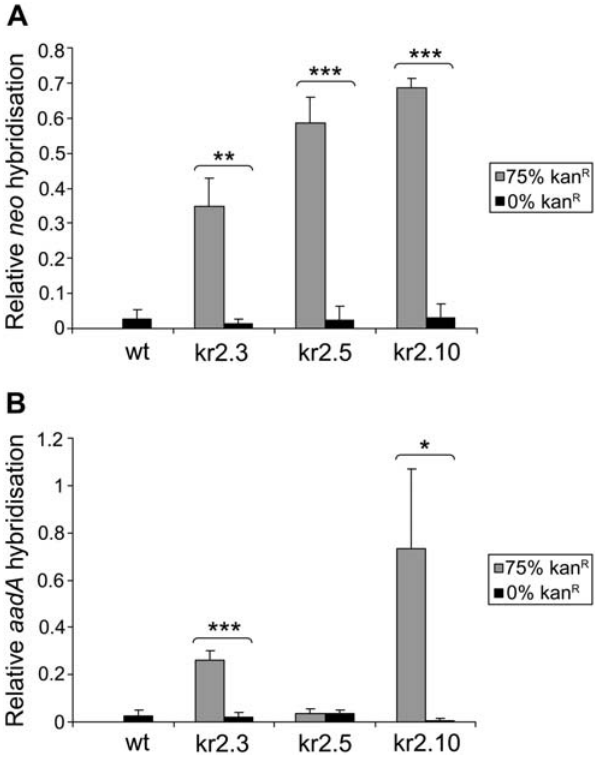
Figure 3. PCR analysis of kr lines with reduced levels of kanamycin resistance. A–C. PCR of neo from 6 plants grown from seeds of a normally segregating self-fertilised seed capsule (75% kan R ) and 6 plants grown from seeds of a capsule which showed no kanamycin resistant progeny (0% kan R ) for each of kr2.3 (A), kr2.5 (B) and kr2.10 (C) (see Figure 1). D. PCR of neo from progeny of a self- fertilised seed capsule of kr2.9 which gave 50% kanamycin resistant progeny. Results for 12 plants are shown; this is representative of a larger experiment in which 36 plants were tested (see text). In all cases control PCRs with rbcS primers are also shown. The neo primers amplify a single product of approximately 800 bp. The rbcS primers amplify two products of approximately 850 bp and 1 kb. -ve no template.